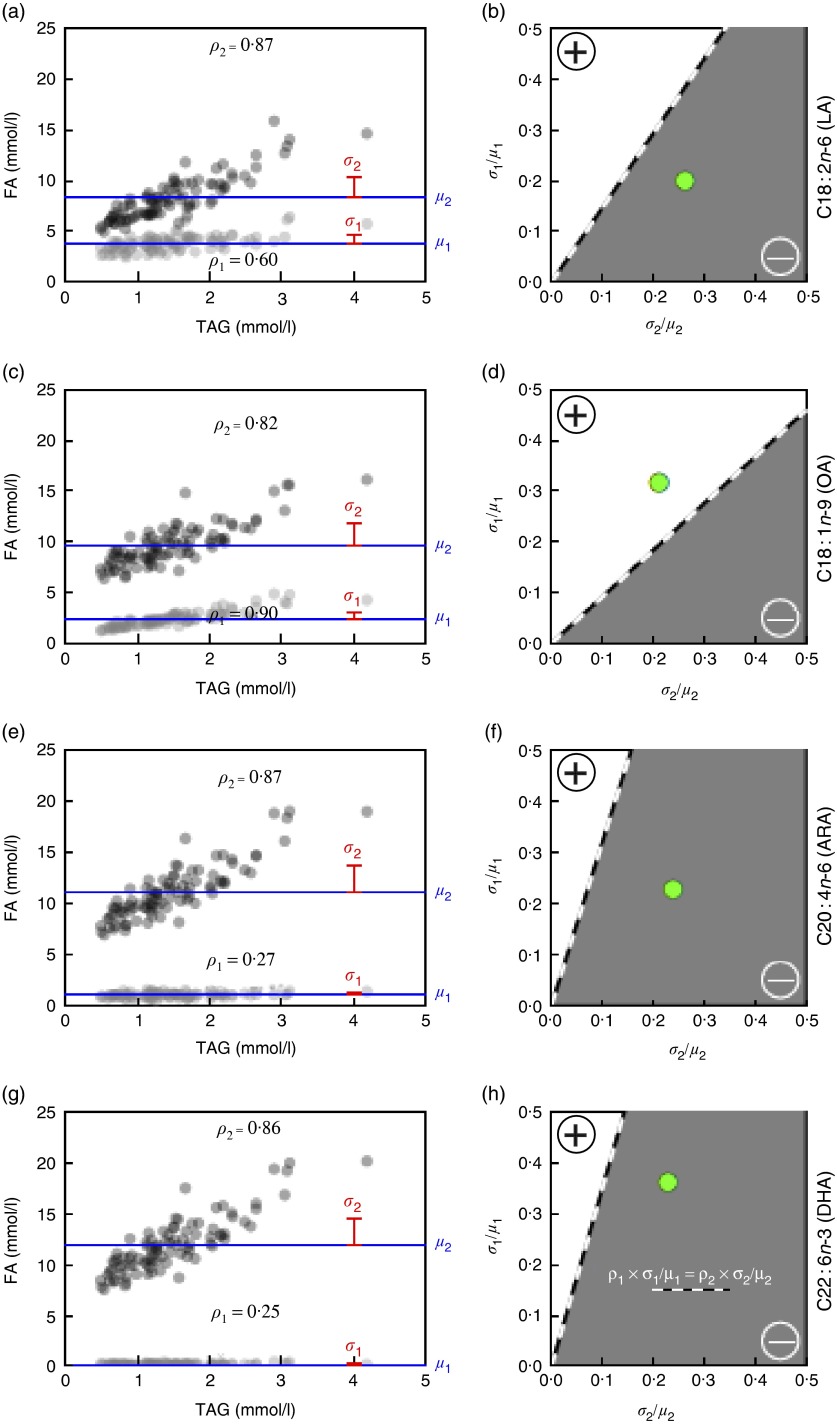
Predicted TAG relationship with (OA, C18 : 1n-9), linoleic acid (LA, C18 : 2n-6), (ARA, C20 : 4n-6) and DHA (C22 : 6n-3) based on fatty acid (FA) concentration and variability (Diet, Exercise, Metabolism and Obesity in Older Women (DEMO) cohort). The TAG levels v. observed FA concentrations (a, c, e, g), indicating serum concentrations of LA (a, ), OA (c, ), ARA (e, ) and DHA (g, ), and total FA concentrations without LA, OA, ARA and DHA, respectively (). Values are means (μ, ) and sd (σ, ), and the sample correlation with TAG (ρ) is shown in the lower (LA, OA, ARA, DHA) or upper (all other FA) part of the respective scatter plots. The correlation between TAG and percentage of total FA will be negative (, b, d, f, h) if, for a given FA, the product of the correlation (ρ
1) with the TAG levels and its CV (σ
1/μ
1) is smaller than the corresponding product for all other FA concentrations combined (ρ
2× σ
2/μ
2). The percentage of total LA, ARA and DHA expected to be negatively correlated with TAG levels (b, f, h) and the percentage of total OA expected to be positively correlated with TAG levels (d). , The observed ratios of means and standard deviations.